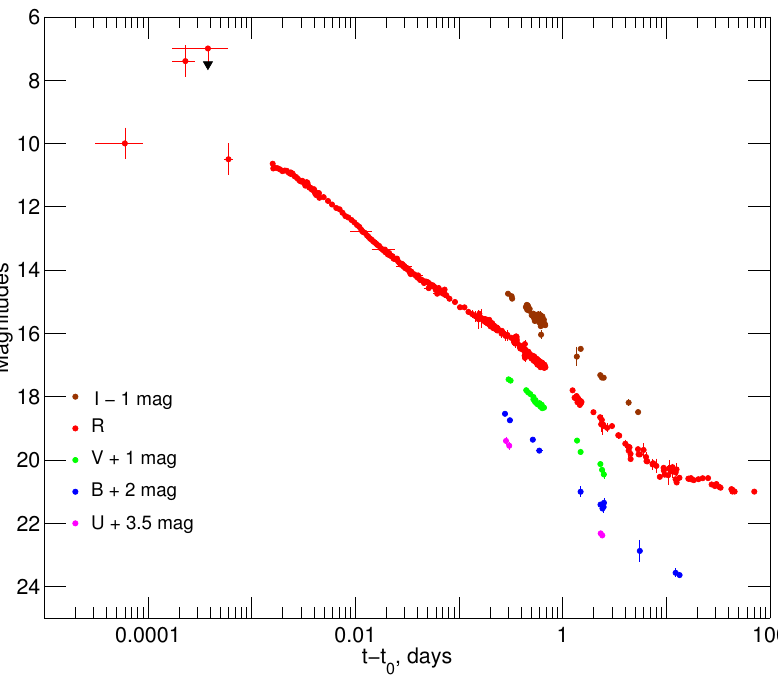
Figure 3. The multicolor optical light curve of GRB 130427A obtained by the instruments of IKI GRB-FuN (USA – New Mexico; Russia – Ussuriysk, Blagoveshensk, Mondy, Crimea, Caucasus; Uzbekistan – Kitab, Maidanak; Georgia – Abastumani; India – ARIES) and some other observatories (SAO RAS, BOOTES-3,